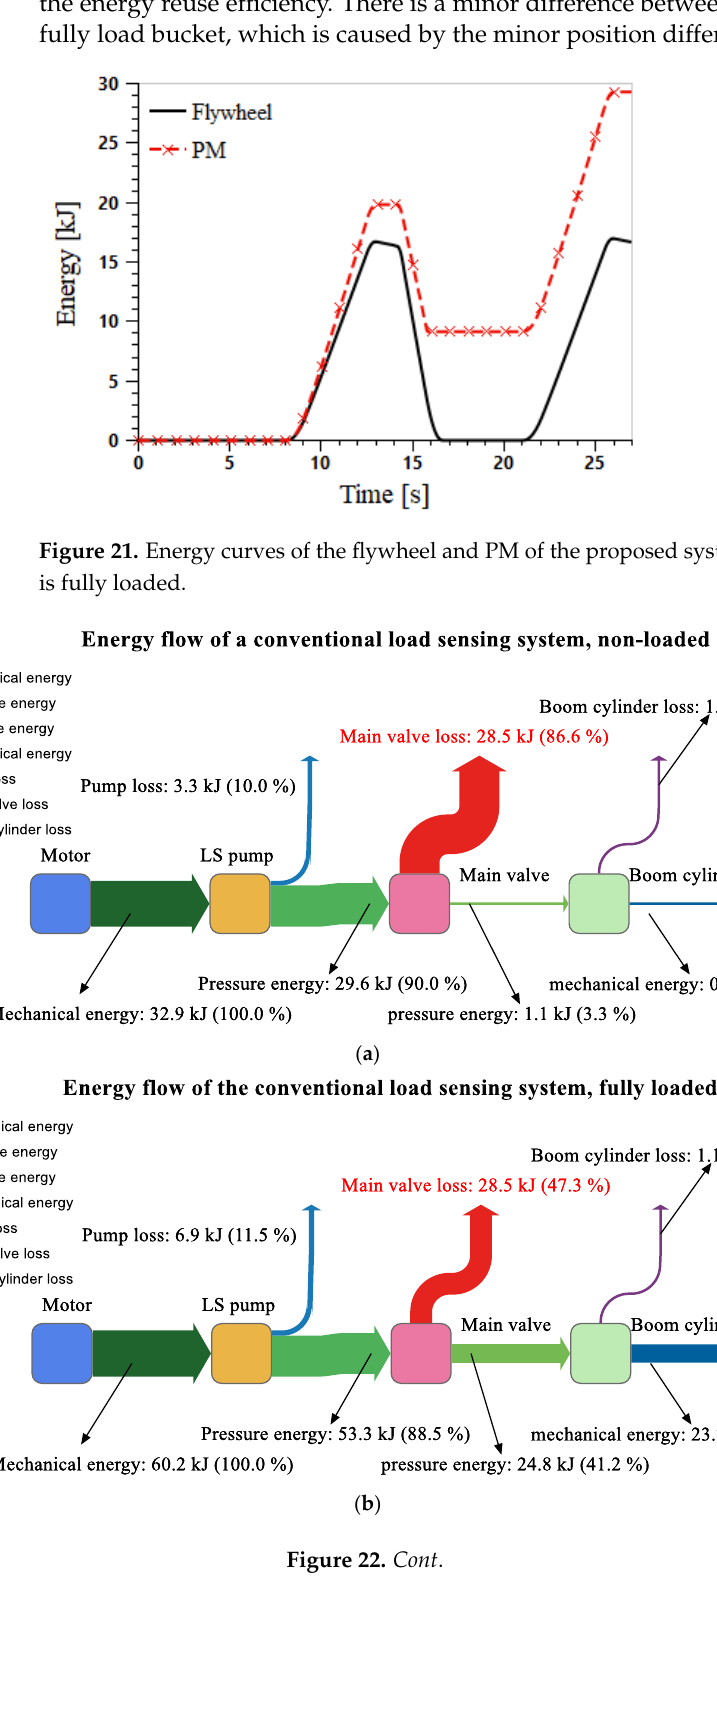
Figure 20. Energy consumption of the proposed system with a fully loaded bucket.